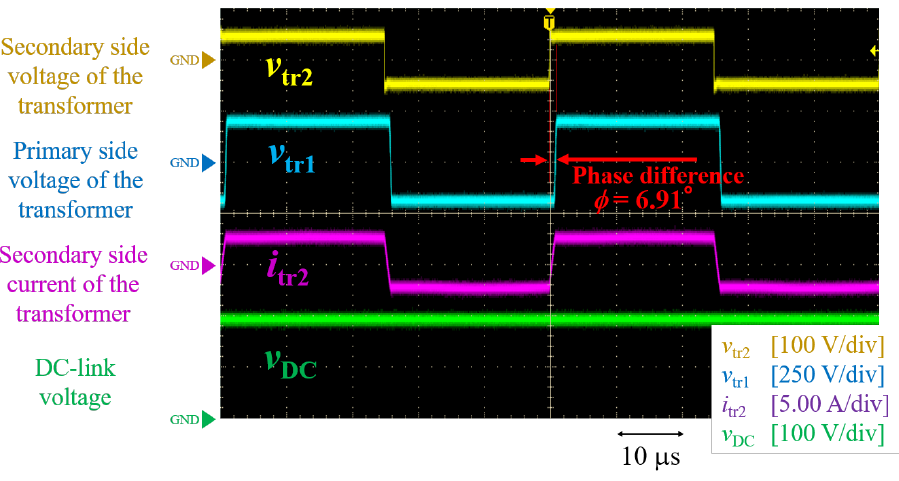
Figure 17. Experimental results of the DAB converter when v bat = 48.0